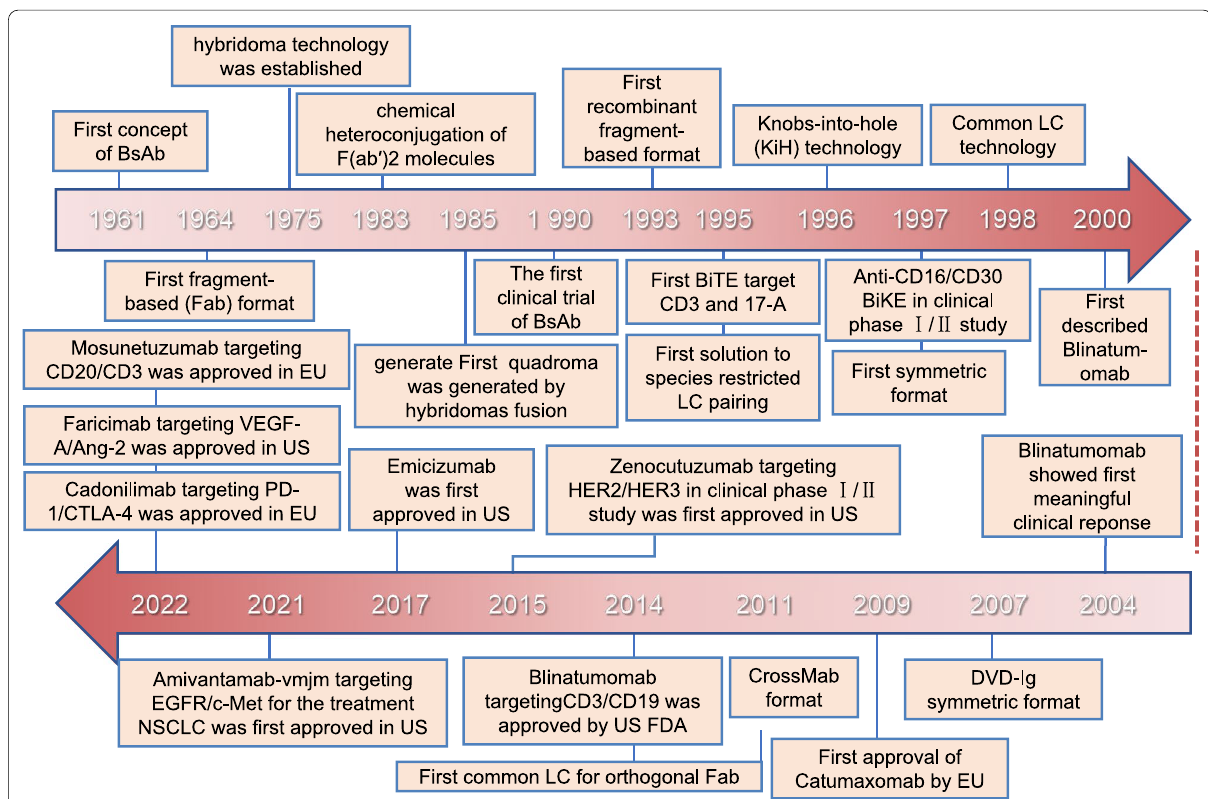
Fig. 4 Timeline of historical bispecific antibody developments and first approval for market. This timeline demonstrates key points in the development of bispecific antibodies. BiKEs, bispecific killer engagers; DVD-Ig, dual-variable-domain